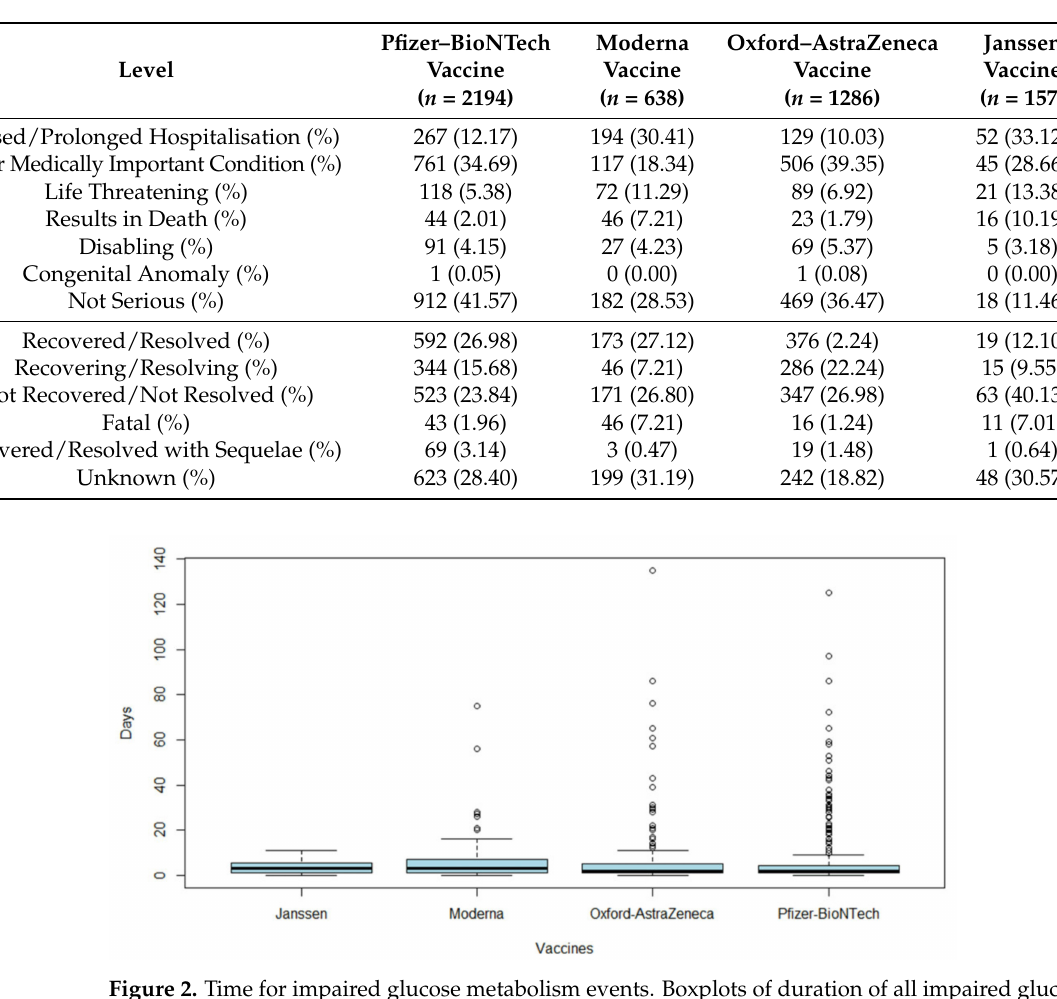
Table 4. Seriousness and outcome of impaired glucose metabolism events distributed by type of